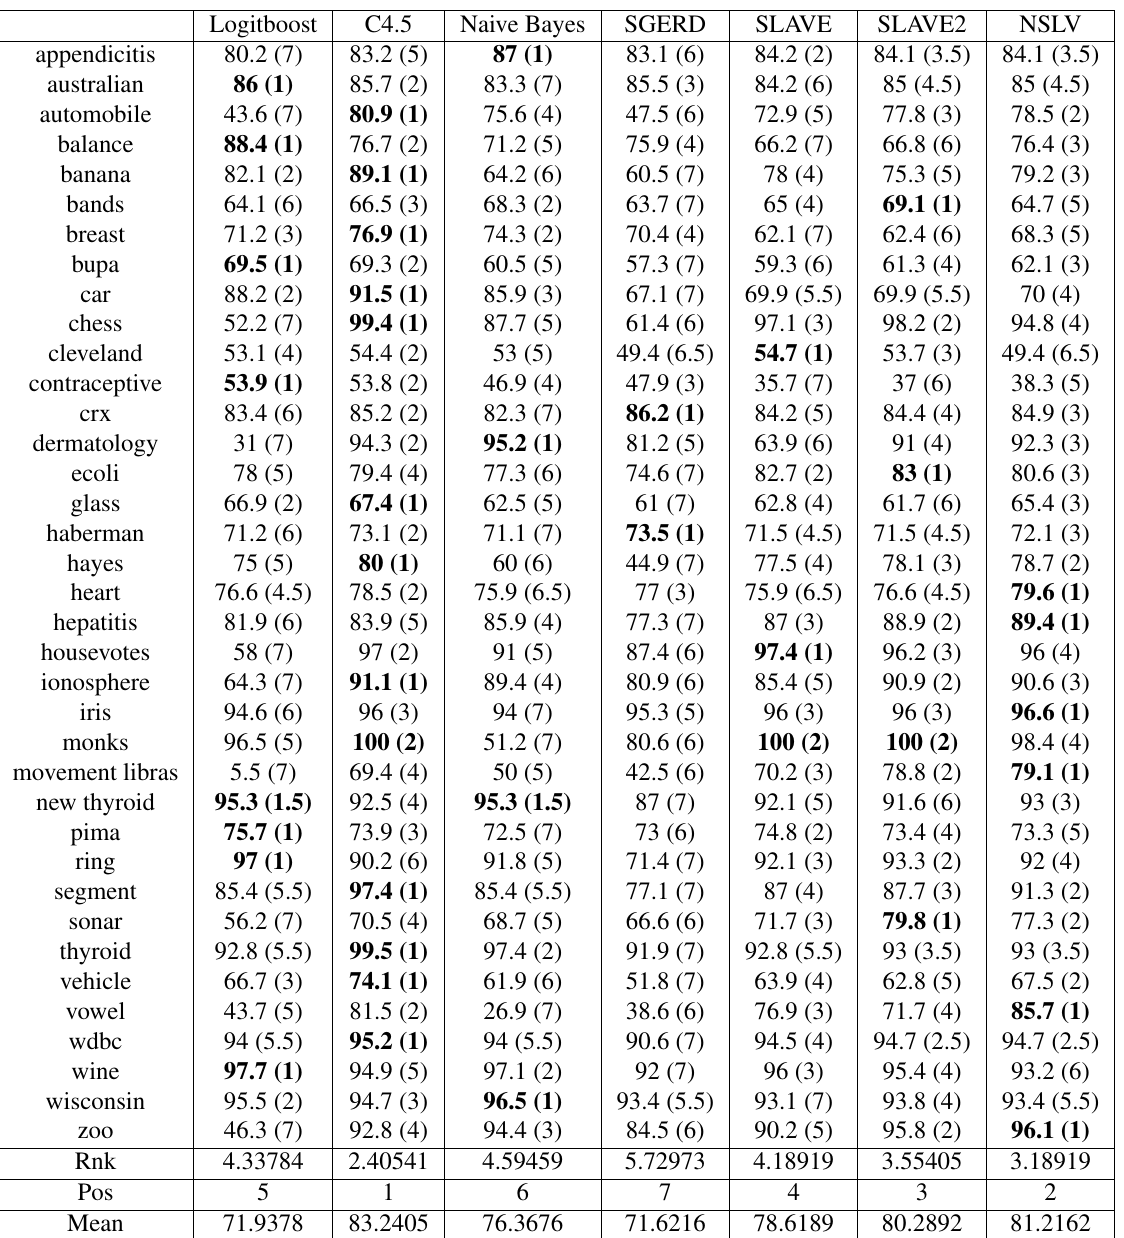
Table 7. Results obtained by several learning algorithms on 37 databases. The Table shows the accuracy on test